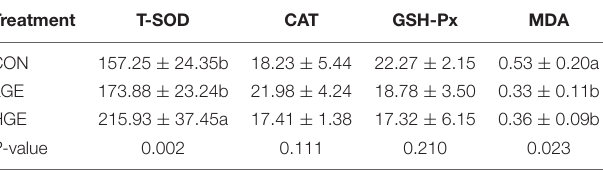
TABLE 7 | Hepatic antioxidant indices.